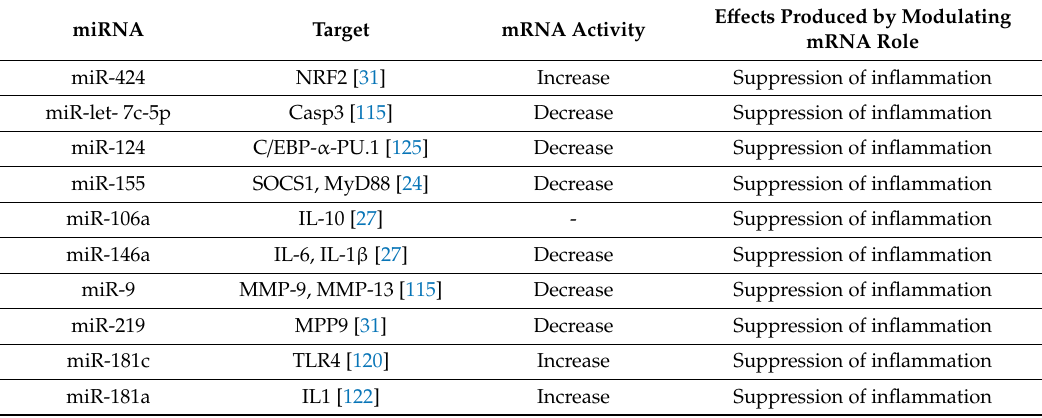
Table 2. The specific role of miRNAs modulating several target genes involved in post-ischemic inflammation.